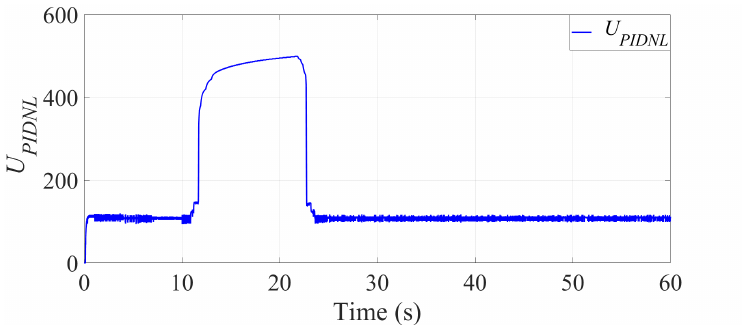
Figure 23. Desired voltage value ( V d ) and performance of the output voltage ( V out ( t ) ) implementing the proposed nonlinear PID controller.